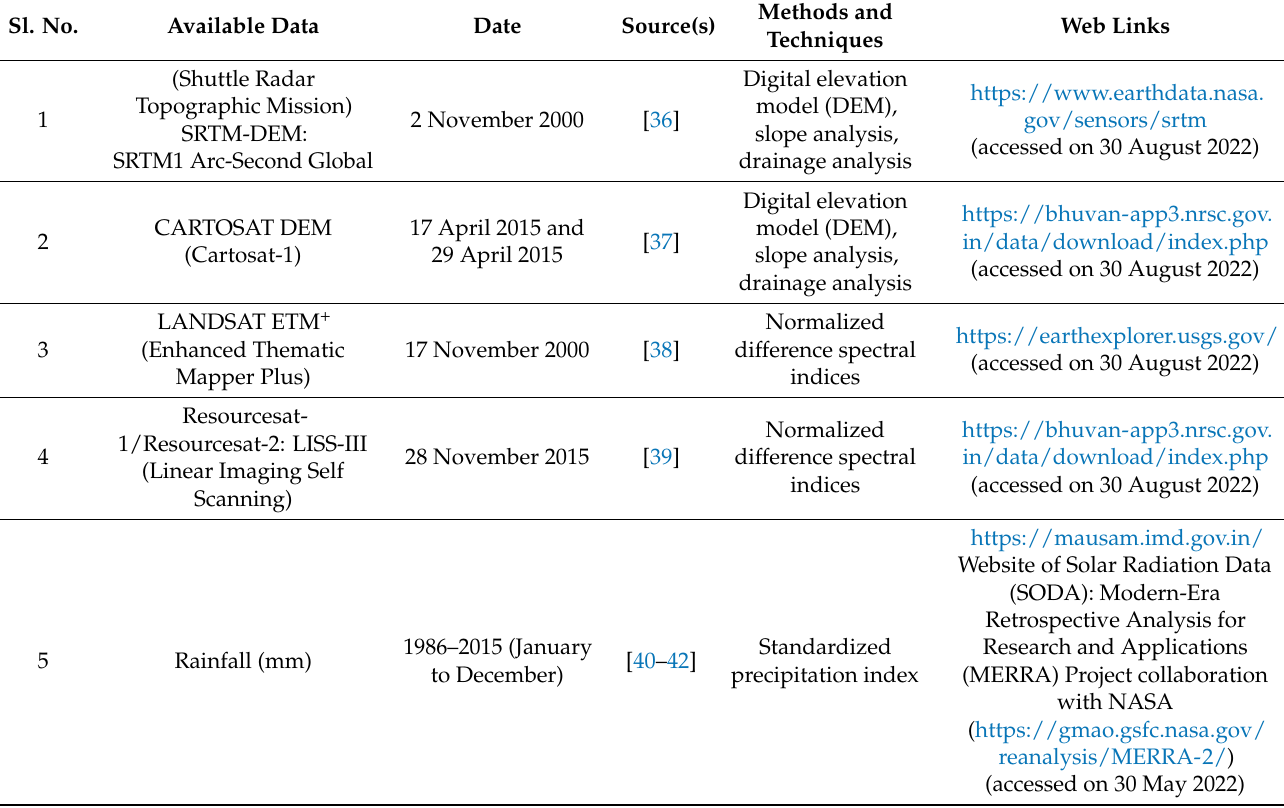
Table 2. Sources and use of available